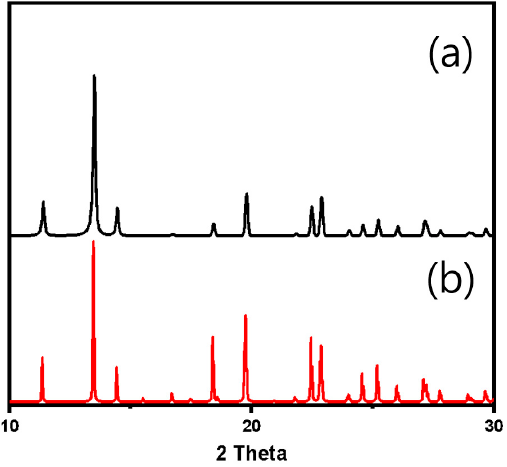
Figure 1. Powder XRD patterns of ( a ) synthesized [Me 4 N] 2 CoCl 4 and ( b ) [Me 4 N] 2 CoCl 4 reference (JCPDS 01-072-0033).